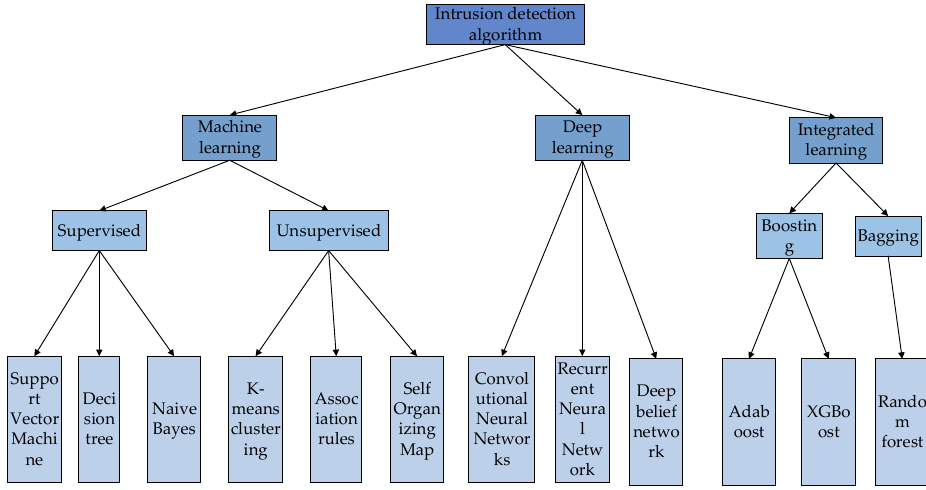
Figure 1. Intrusion detection algorithms.